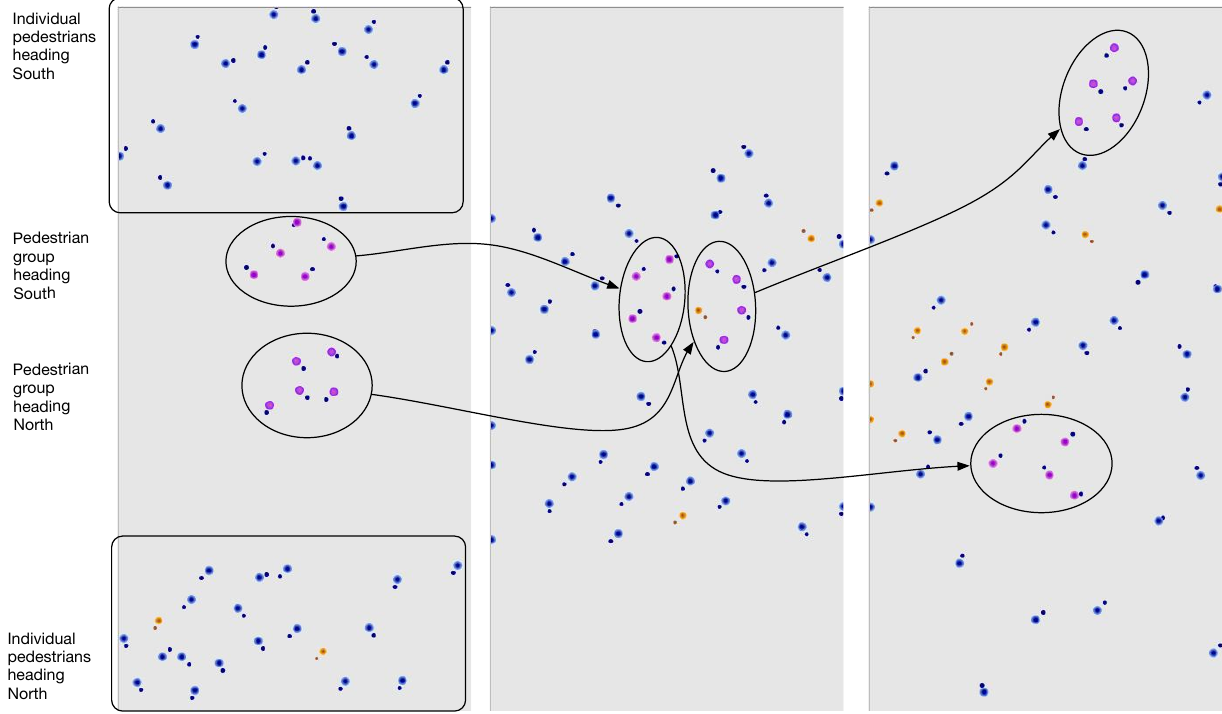
Figure 5. Screenshots of the prototype of the simulation